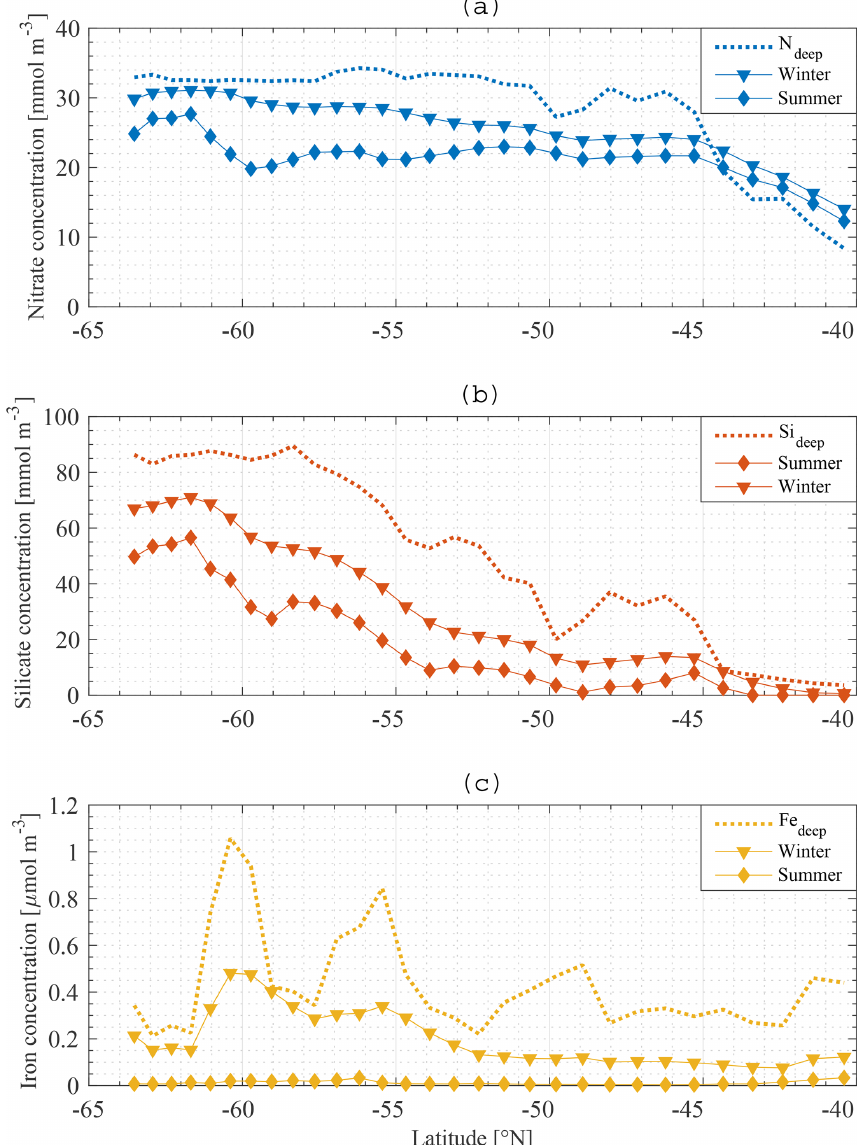
Figure 9. Model result: summer ( (cid:7) ) and winter ( (cid:72) ) nitrate (a) , silicate (b) and iron (c) concentrations in the mixed layer along the average meridional section compared to the deep-water concentration ( ...